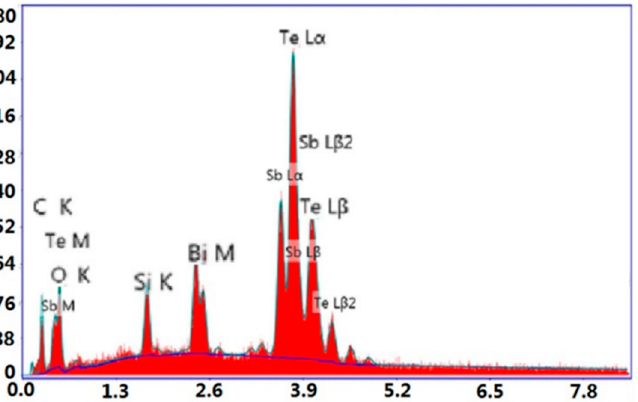
Figure 3. EDX spectrum of the (Bi 0.48 Sb 1.52 )Te 3 thick film annealed at 550 °C for 1 h in 10 − 2 Pa vacuum.